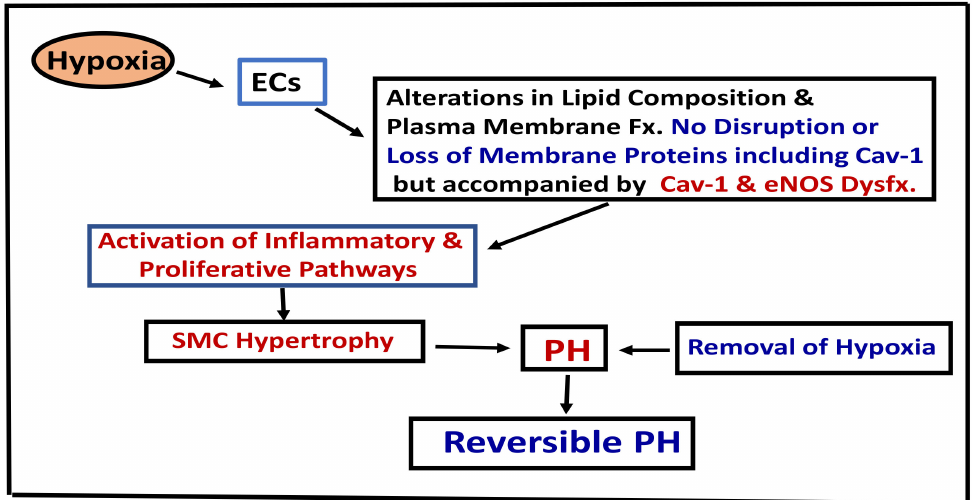
Figure 2. This figure depicts the pathways leading to hypoxia-induced PH. Cav-1 (Caveolin-1), Fx (function), Dysfx (dysfunction), ECs (endothelial cells), PH (pulmonary hypertension), SMC (smooth muscle